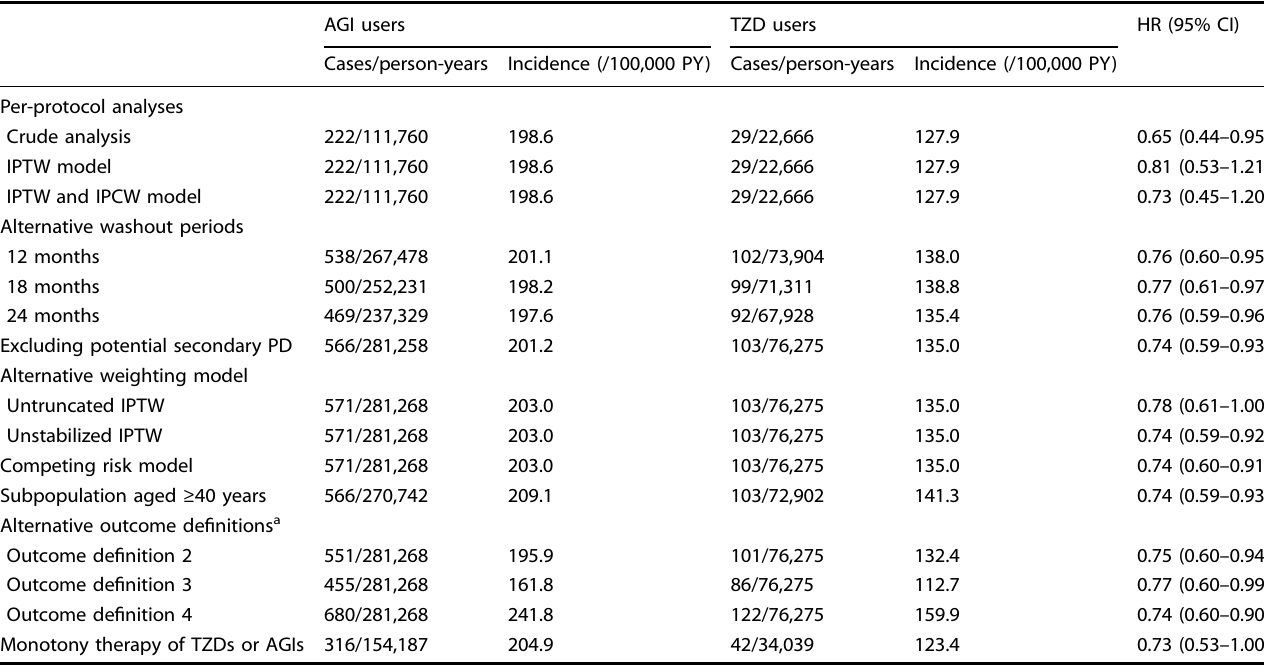
Table 3. Results of per-protocol and sensitivity analyses.